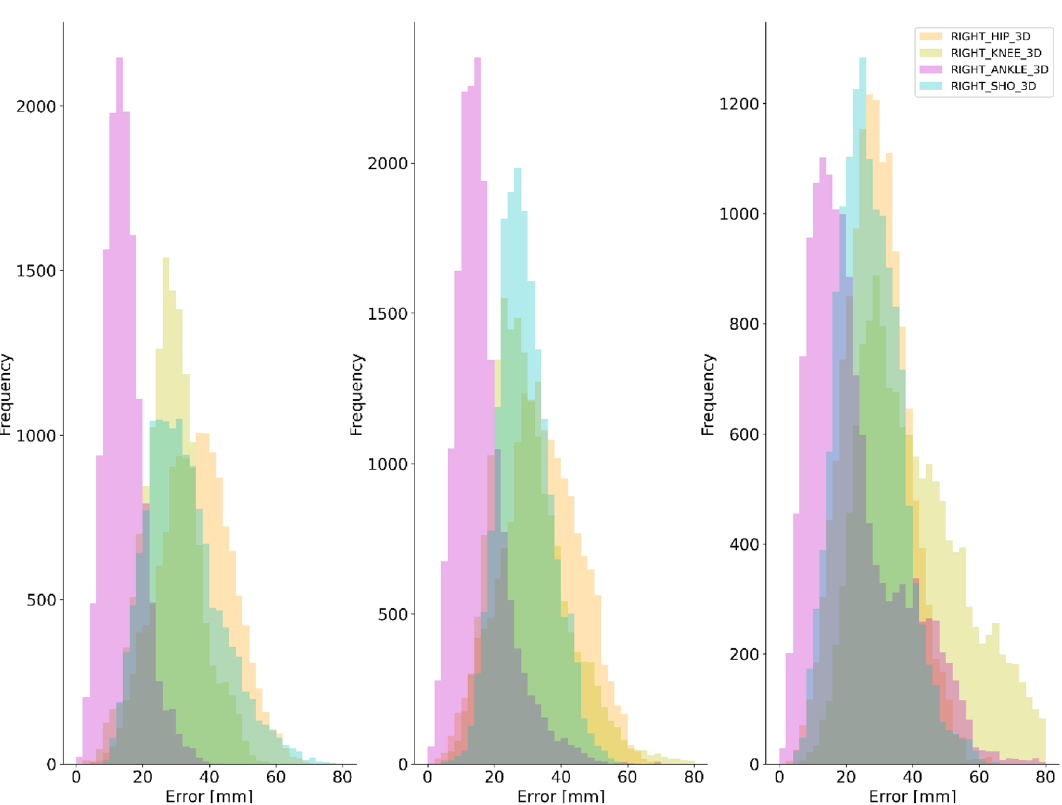
Figure 4. Example difference distributions for OpenPose at the right shoulder, hip, knee and ankle joint centres for jumping (left), walking (centre) and running